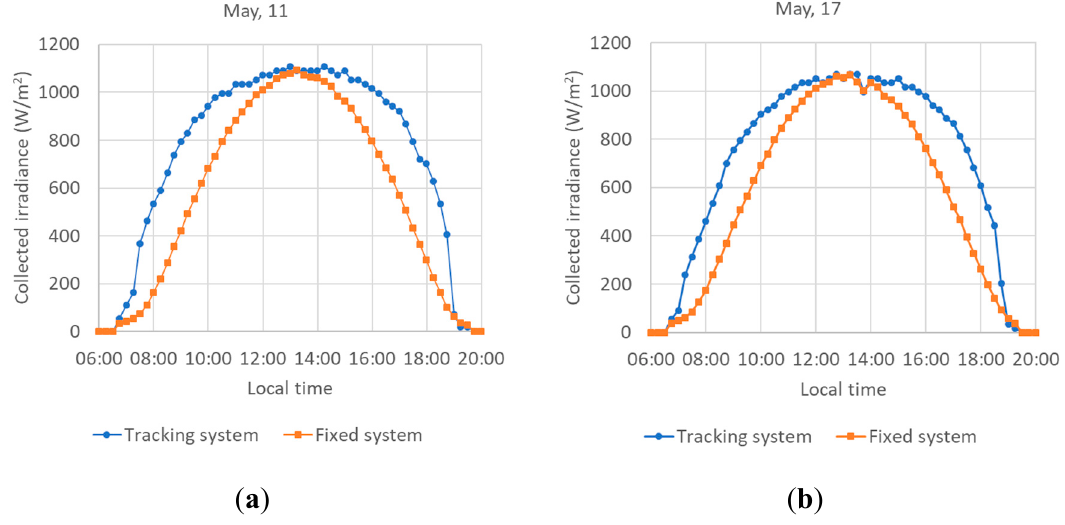
Figure 14. Irradiance measurements over May 11 ( a ) and May 17 ( b ) for the tracking and the fixed systems.